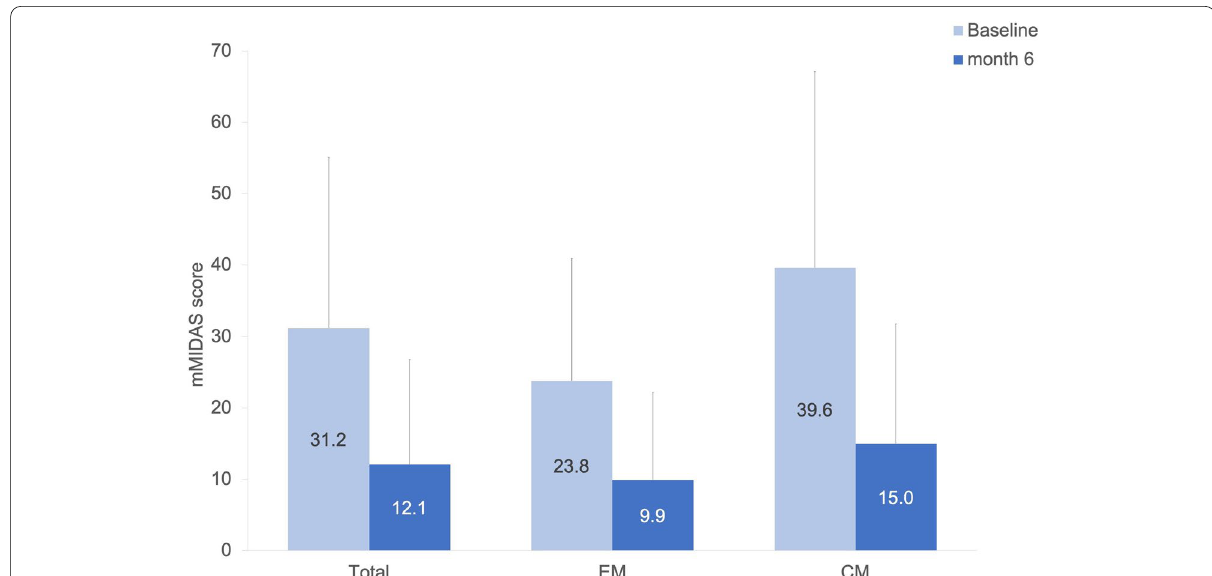
151). Abbreviations: EM: episodic migraine; CM: chronic =